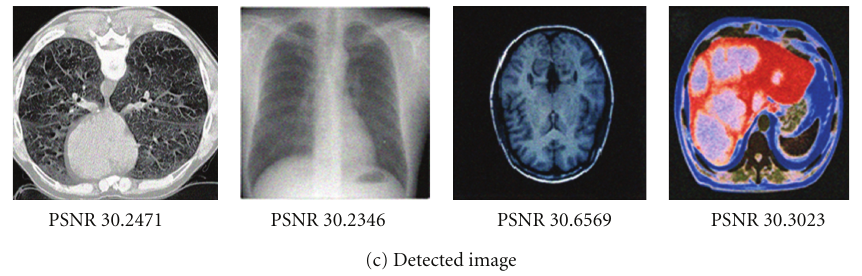
Figure 9: PSNR values of sample biomedical images: sample biological images through PPM TH-ZCZ UWB/MIMO (2 × 2)